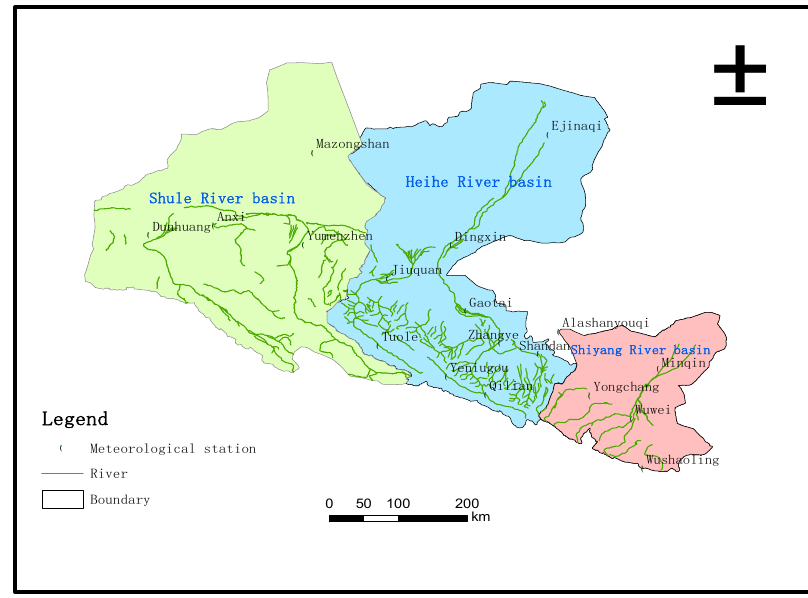
Figure 1. The locations of the meteorological stations in the Hexi Inland River Basin in China.